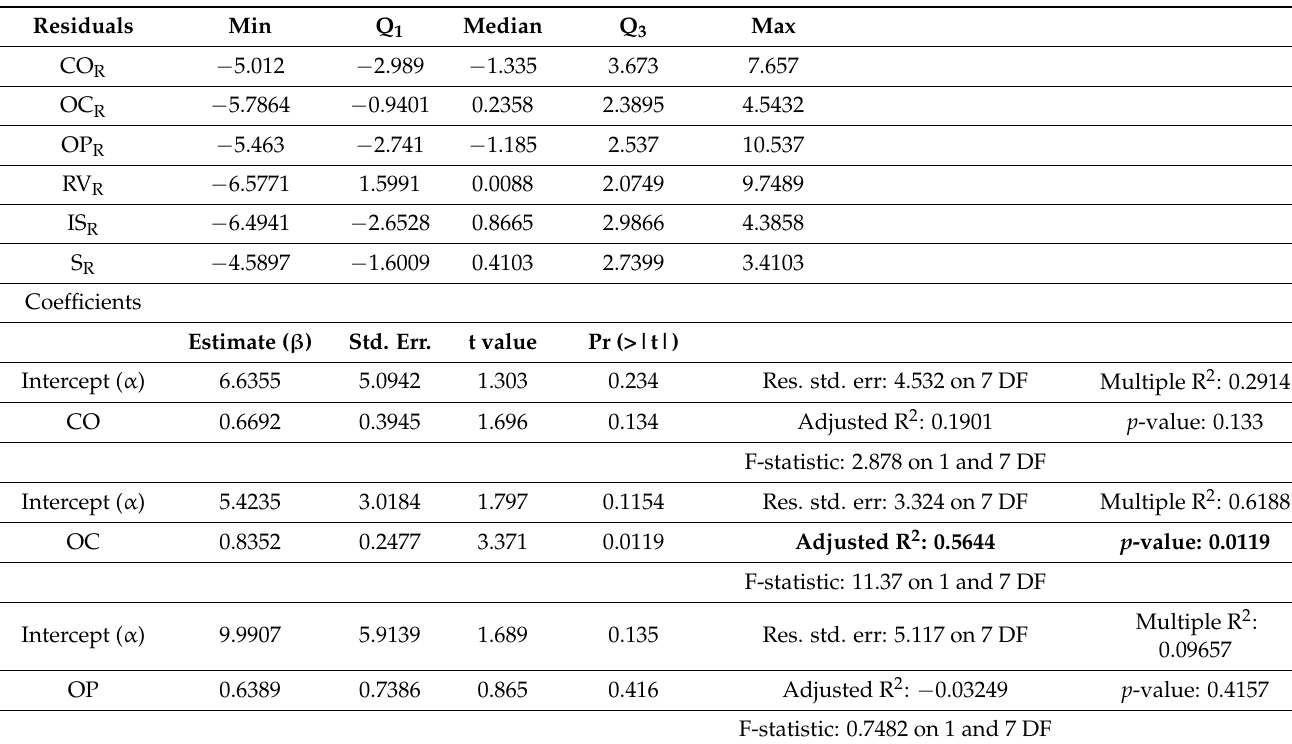
Table 6. Initial explanatory variables simple linear